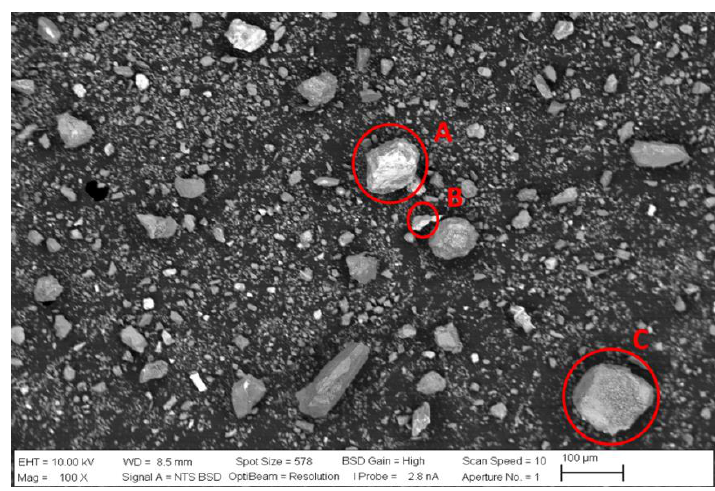
Figure 1. SEM image of mineral ore ( × 100).